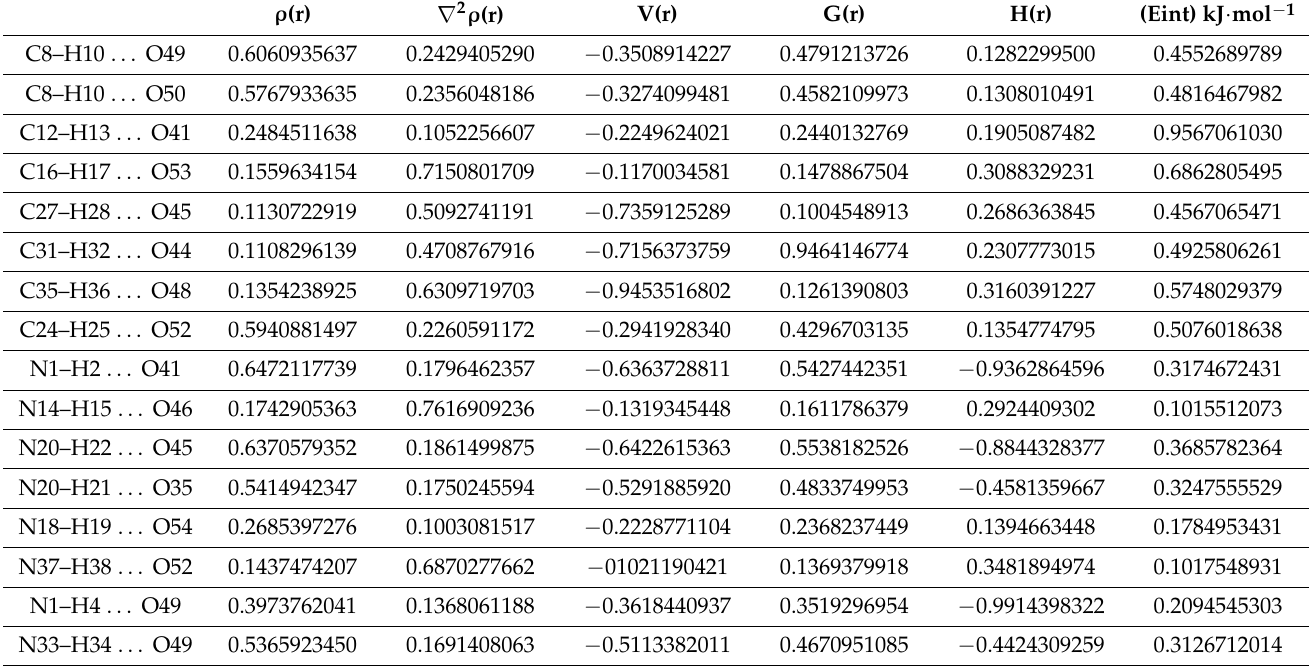
Table 4. Topological parameters of